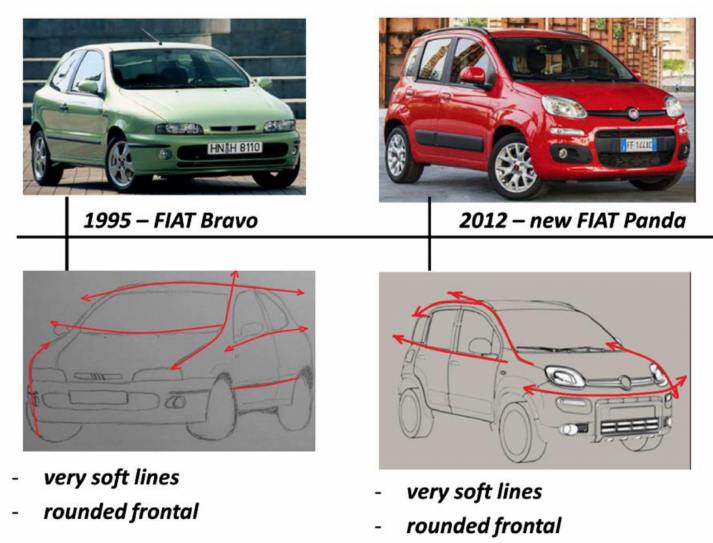
Figure 15. Stylistic evolution of FIAT car city models.